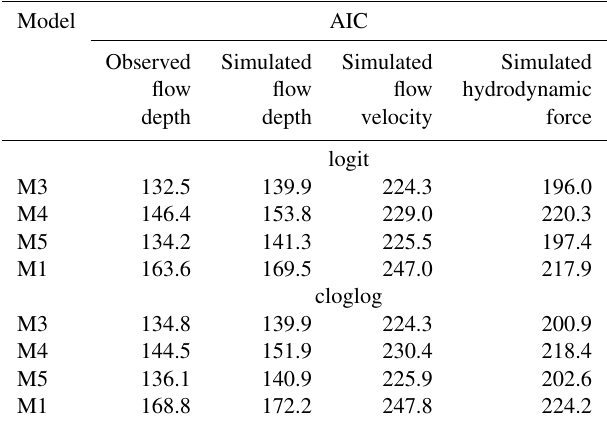
Table D1. AIC values for the three models assuming logit and cloglog link functions fitted to the observed and simulated tsunami intensity measures of